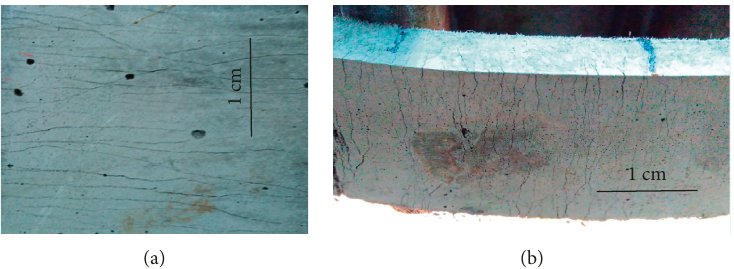
Figure 5: Multiple microcracking patterns under different loading. (a) Crack under uniaxial tensile loading. (b) Crack under flexural loading.